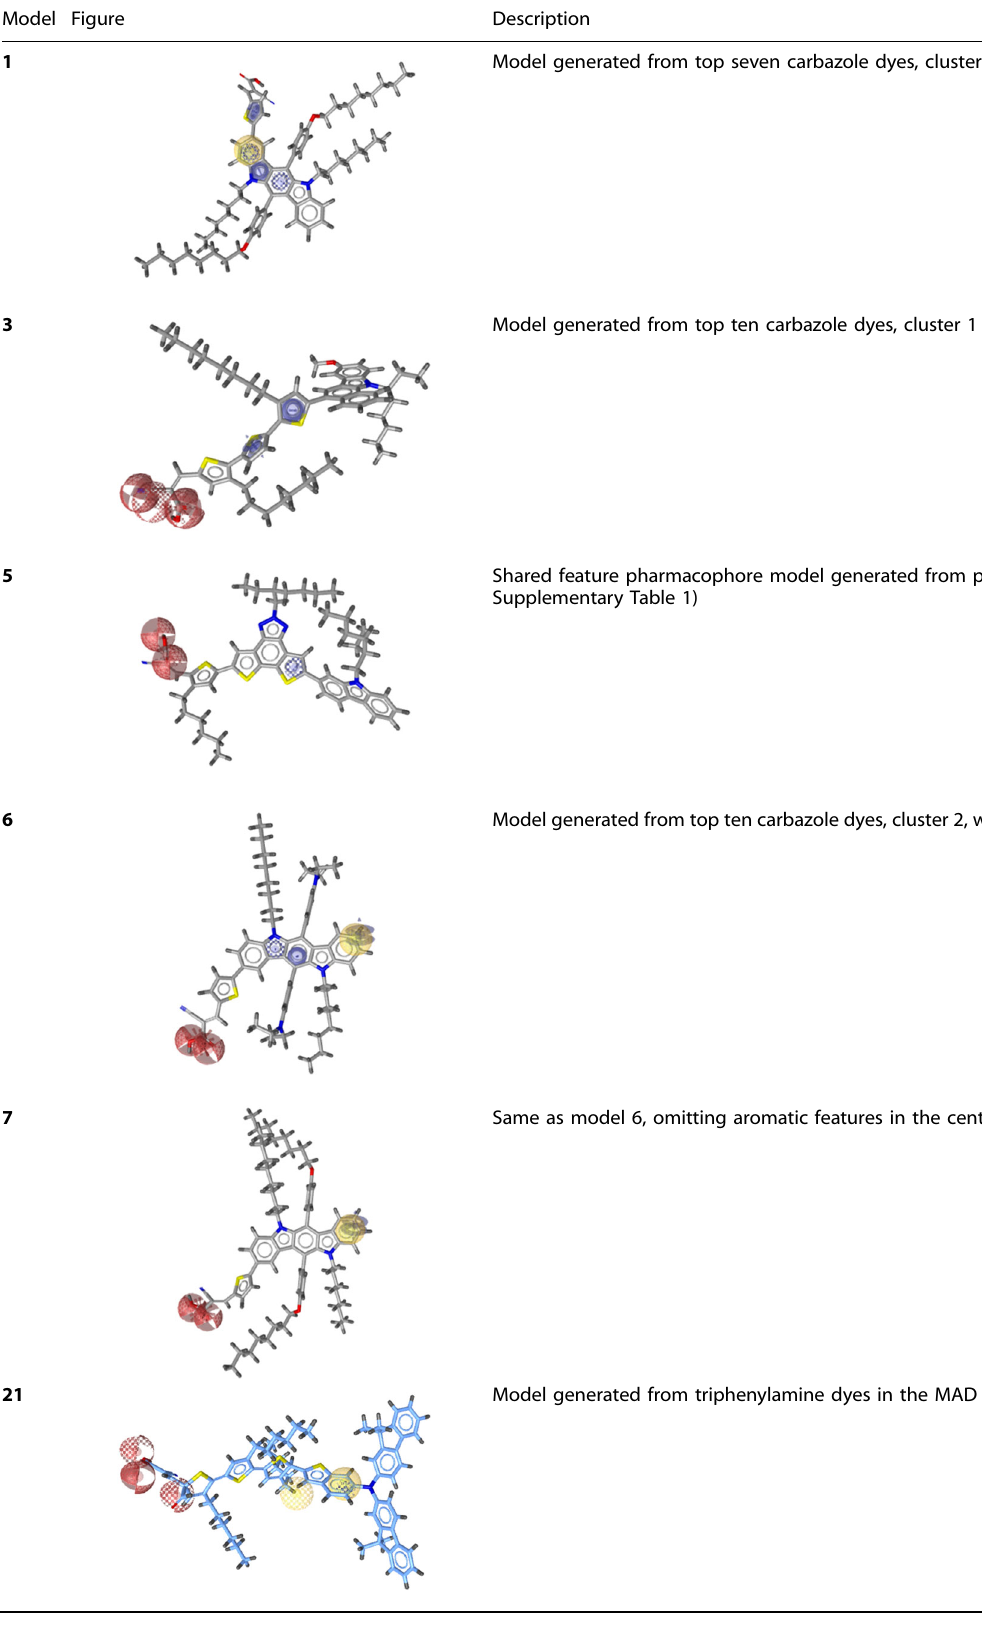
Table 3. Selected pharmacophore models created from dyes with high PCE. Model